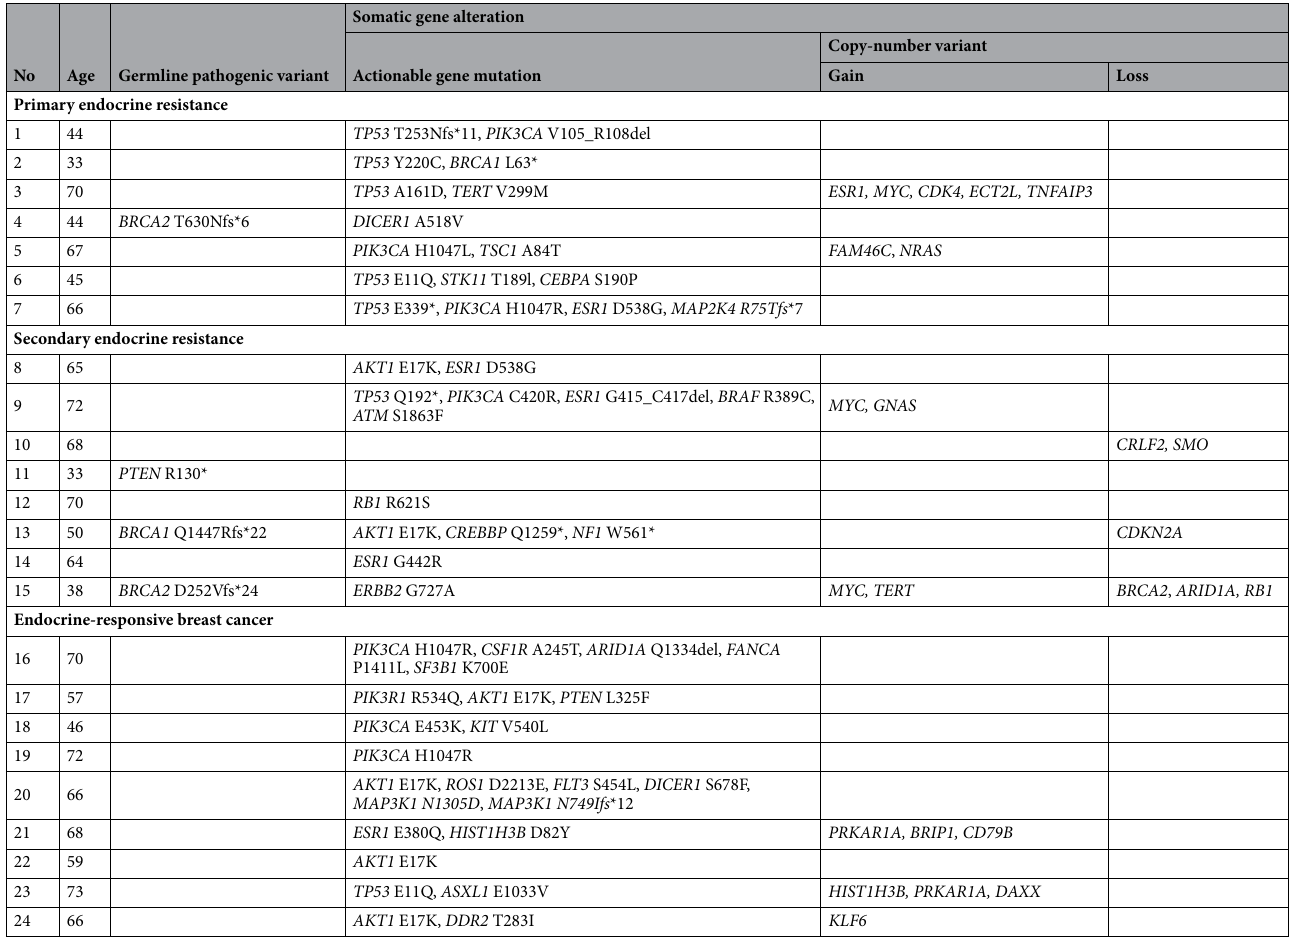
Table 3. Germline and somatic gene alterations in 24 patients according to endocrine responsiveness. Age age at the time of clinical sequencing (years).